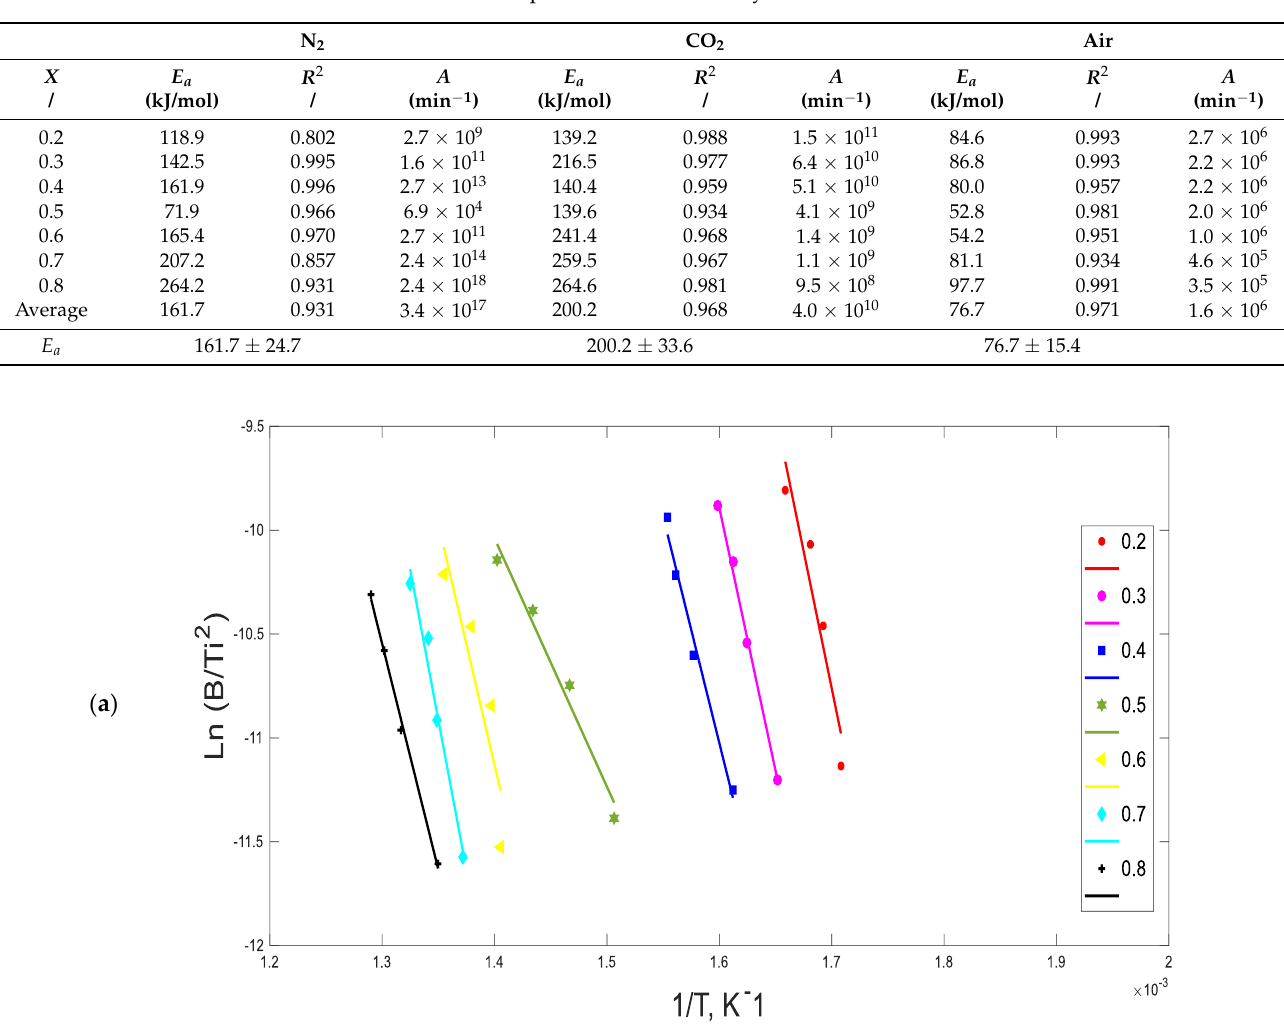
Table 6. Kinetic parameters obtained by OFW method.